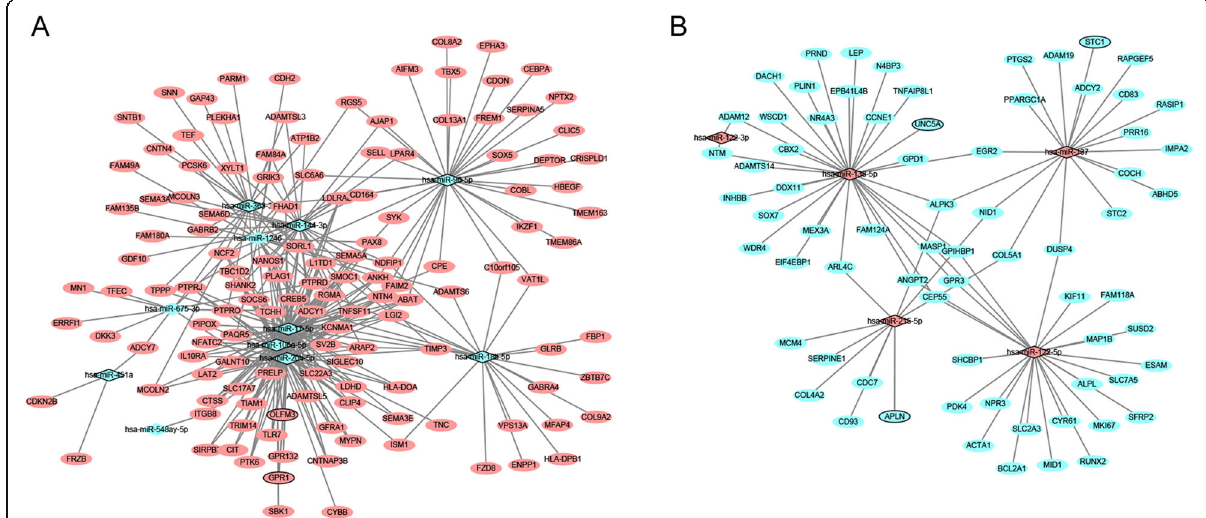
Fig. 4 DEmiRNA-DEmRNA interaction network. a Interaction network between down-regulated DEmiRNAs and up-regulated DEmRNAs; b Interaction network between up-regulated DEmiRNAs and down-regulated DEmRNAs. The rhombic nodes and elliptical nodes indicate DEmiRNAs and DEmRNAs, respectively. Red and green color represent up-regulation and down-regulation,